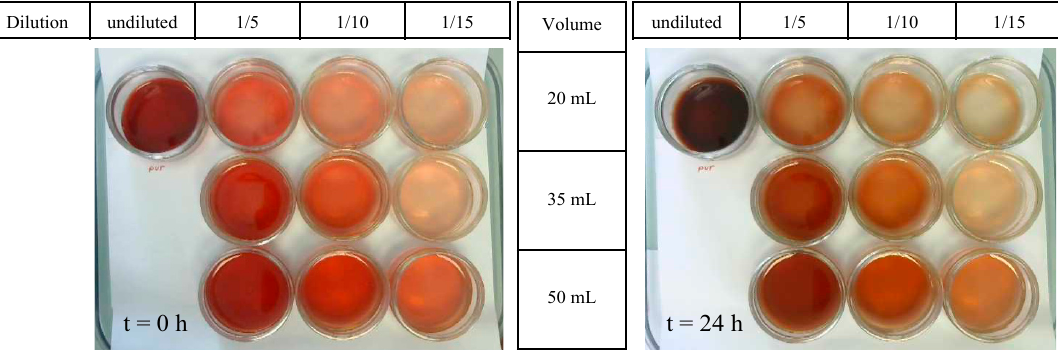
Figure 1. Visualization of the color of the same rib steak juice with di ff erent volumes (20 mL, 35 mL, and 50 mL) and di ff erent dilutions (1 / 5, 1 / 10, and 1 / 15) at t = 0 h and t = 24 h, at 20 ◦ C. Pure meat juice (undiluted) is also presented for comparison to diluted